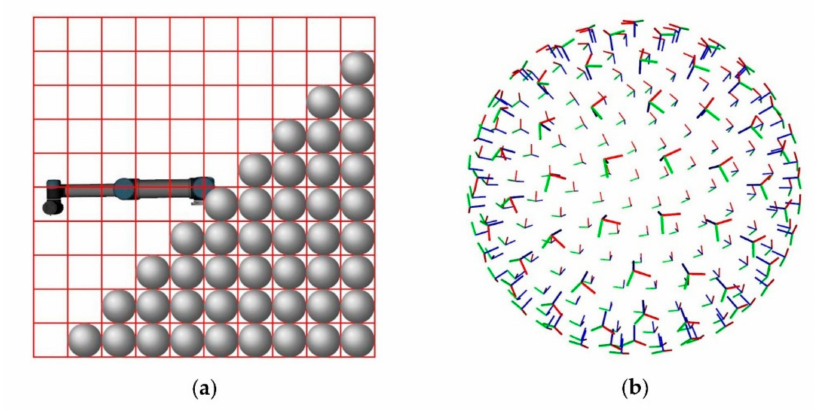
Figure 13. Workspace analysis. ( a ) Schematic of the workspace divided into a voxel grid; ( b ) spherically arranged set of 6D poses P ee for one